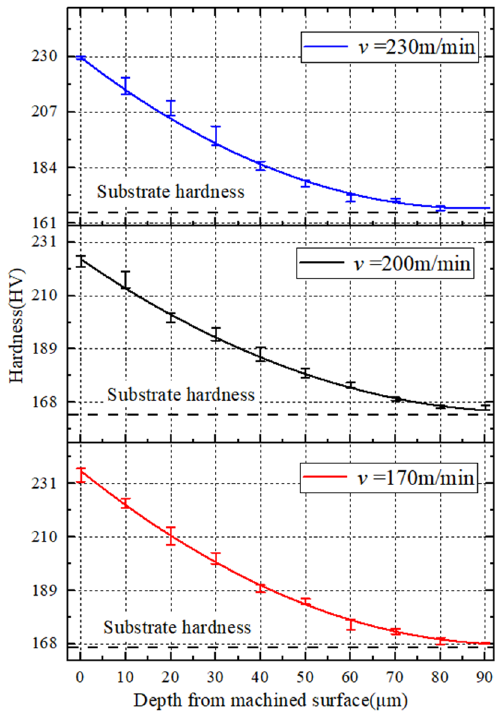
Figure 17. ( 𝑓 = 0.1 mm/r) Influence of cutting speed on work hardening. Figure 17. ( f = 0.1 mm/r) Influence of cutting speed on work